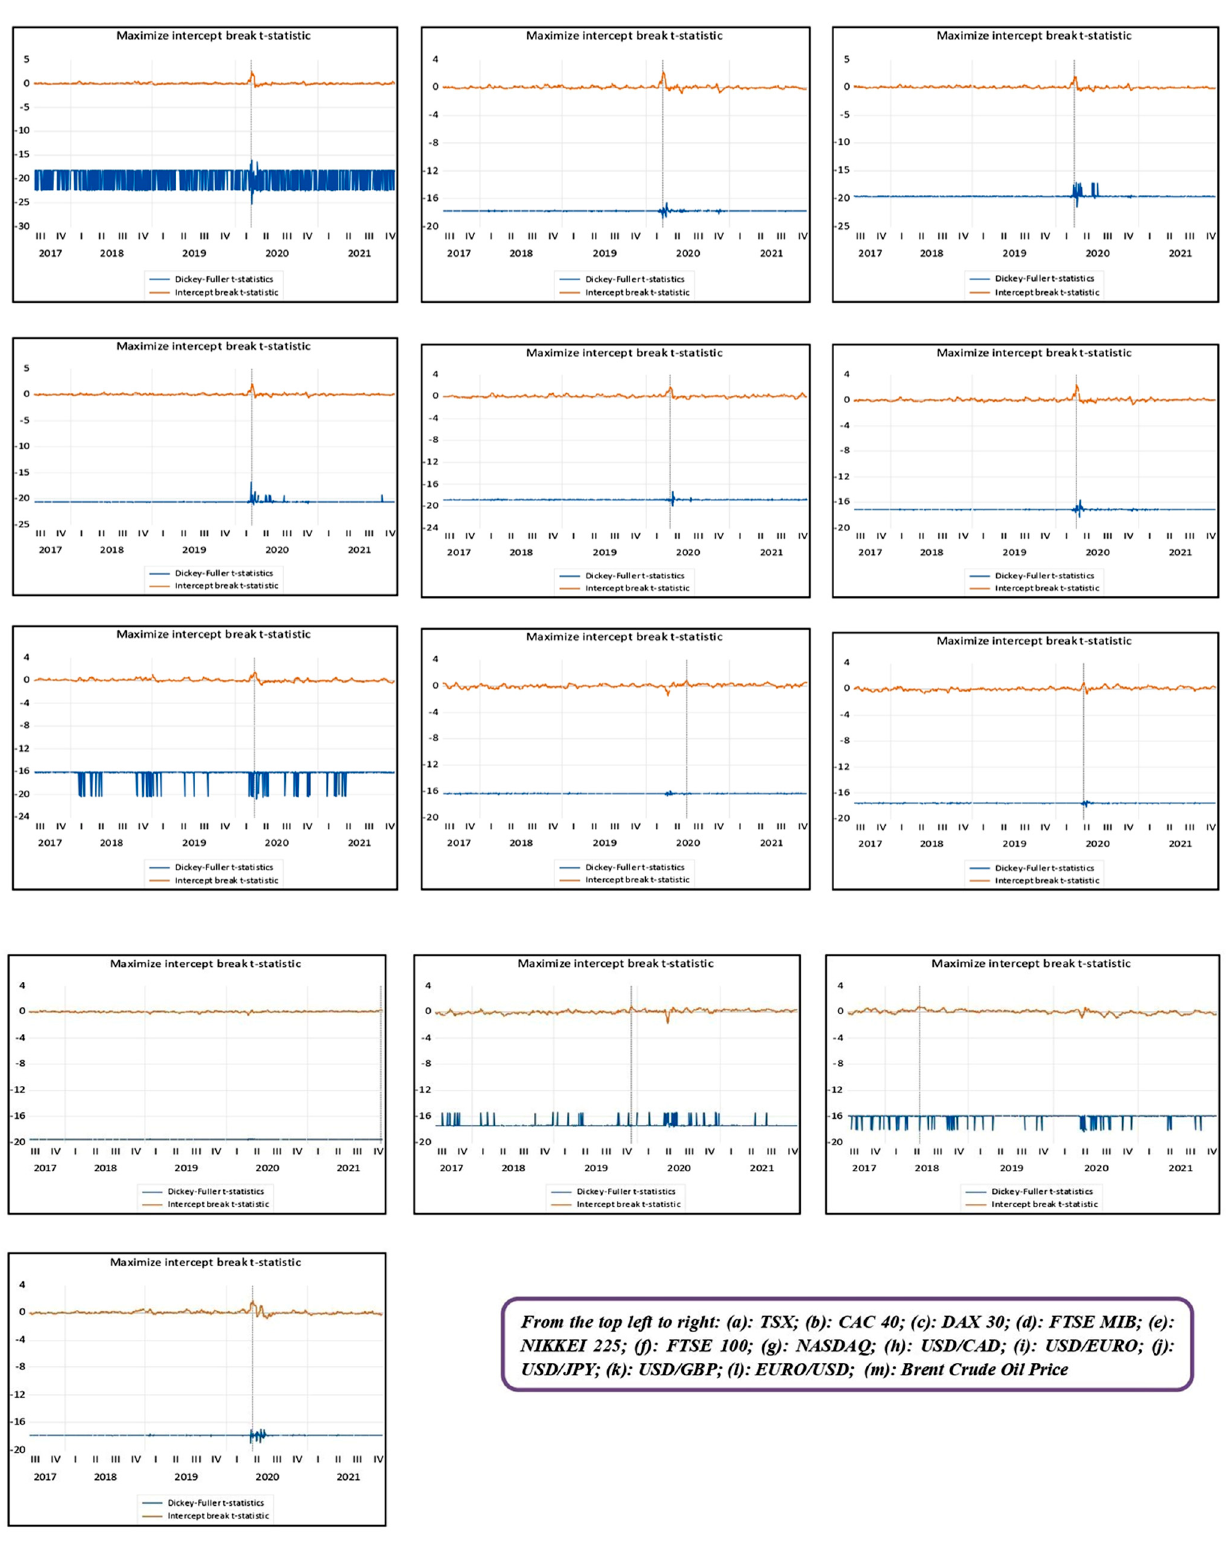
Figure 3. Graphical Representation of Breakeven Unit Root Tests (at level) of the Stock price Returns and Currency Exchange Rates of G7 Countries including Brent Crude Oil Price Returns. Note: X axis measures the time periods as represented by observations to demonstrate the impact of structural breaks in stationarity. The series plotted above shows a structural break in the level and clearly does not revert around the same mean across all of time.